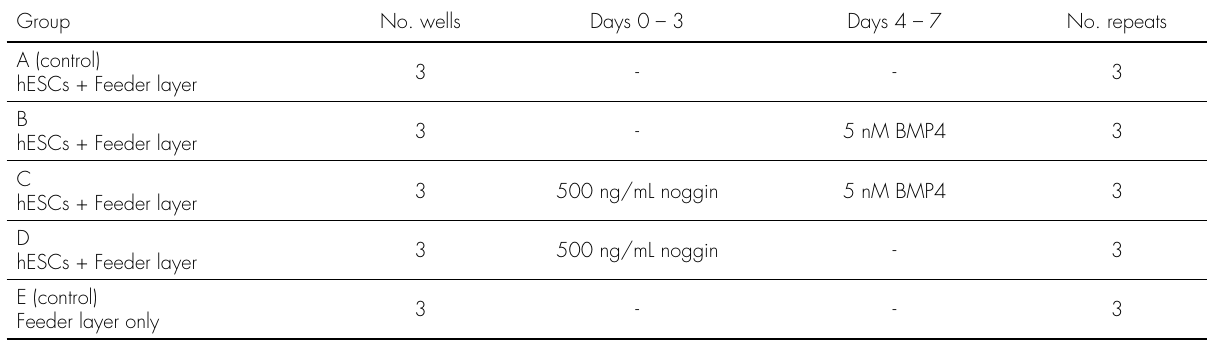
Table I. Experimental conditions for Groups A to